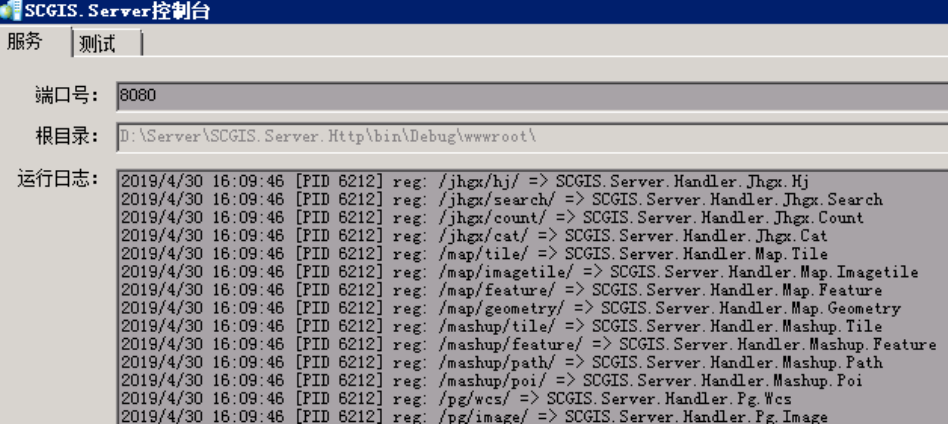
Figure 8. Server console. This is the server host. We can set the IP address, port, and resource root directory of the service; start, stop, browse, and test the service; and monitor the registered handler and its processing exception information. The actual service processing host is completed by another node program, which is an entry shell program.